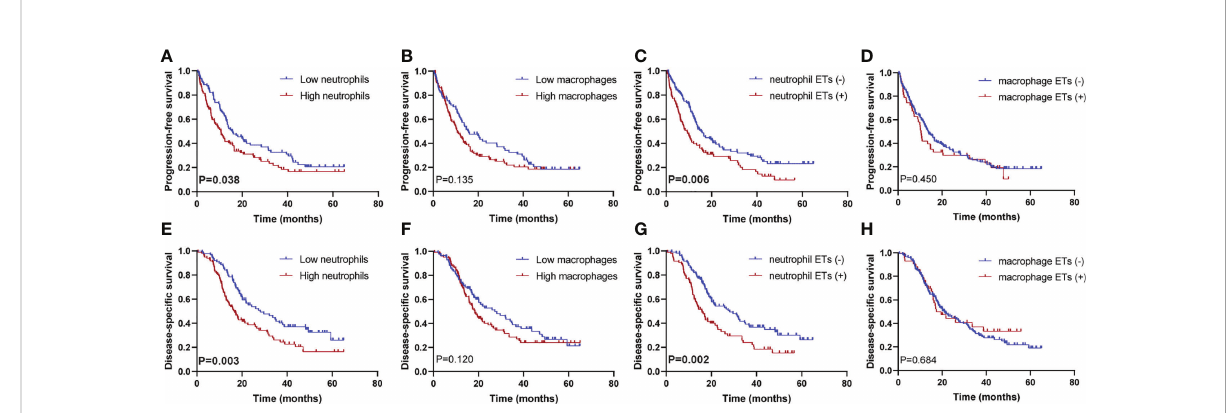
FIGURE 3 Kaplan – Meier survival curves according to neutrophil or macrophage in fi ltration or ETs. Progression-free survival for (A) neutrophil in fi ltration (P=0.038), (B) macrophage in fi ltration (P=0.135), (C) neutrophil ETs (P=0.006), and (D) macrophage ETs (P=0.450); disease-speci fi c survival for